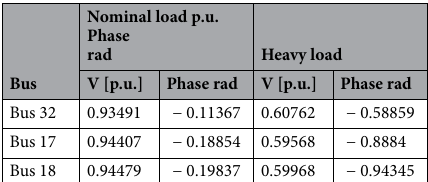
Nominal load p.u.